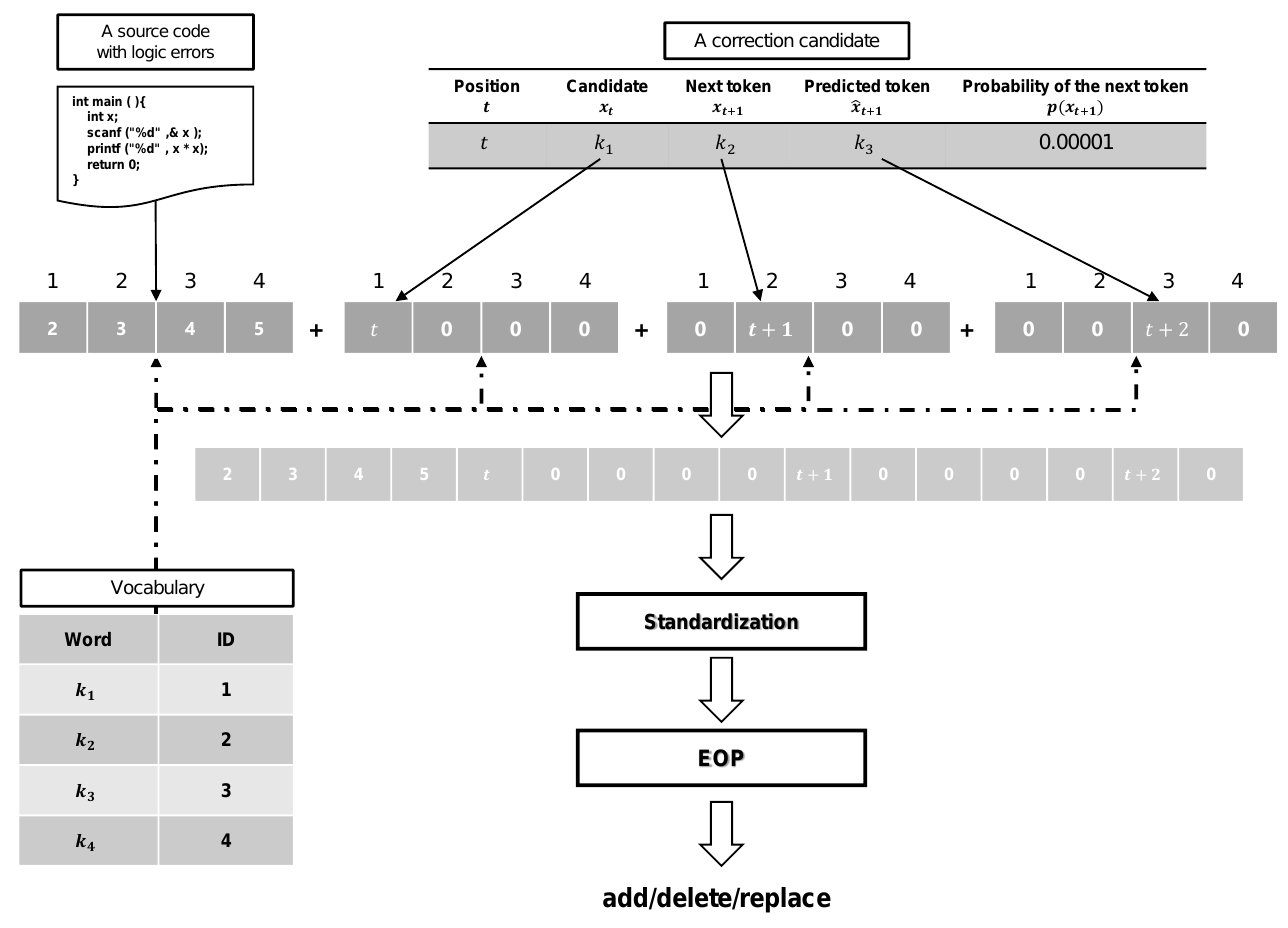
Figure 3. Role of the